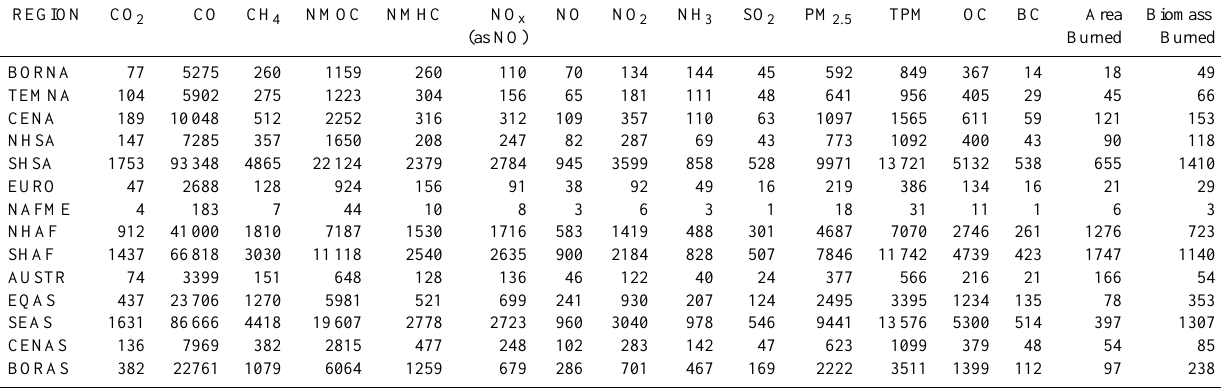
Table 8. Annual average emissions, area burned, and biomass burned (2005–2009) for the regions shown in Fig. 1. All emissions have the units Ggyr − 1 , except for CO 2 , which has units Tgyr − 1 . Area burned is shown in km 2 · 1e − 3 and biomass burned is shown in Tgyr − 1 .